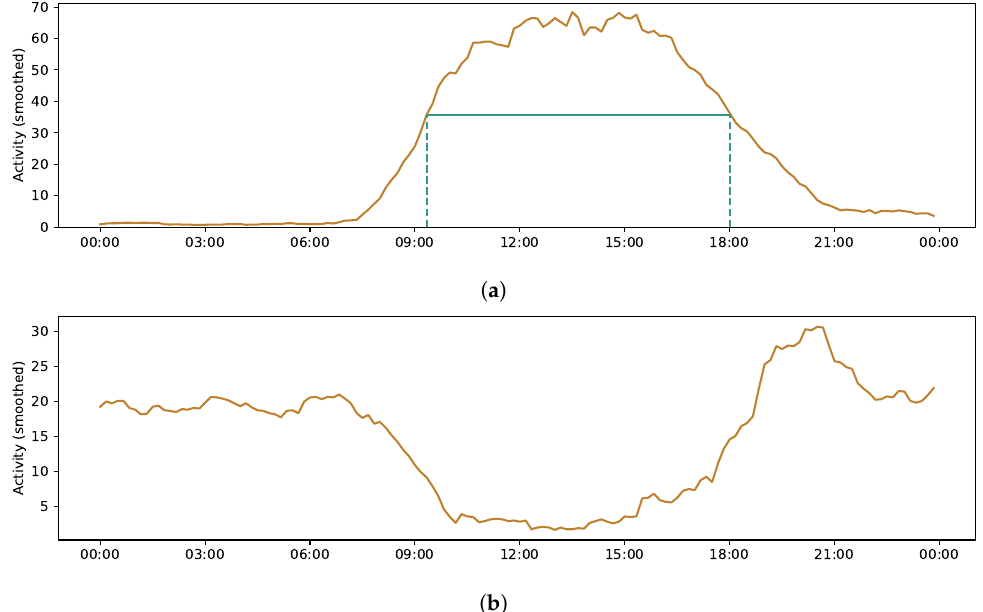
Figure 16. Activity of the workers ( a ) and the inhabitants ( b ) of a selected site, on a selected